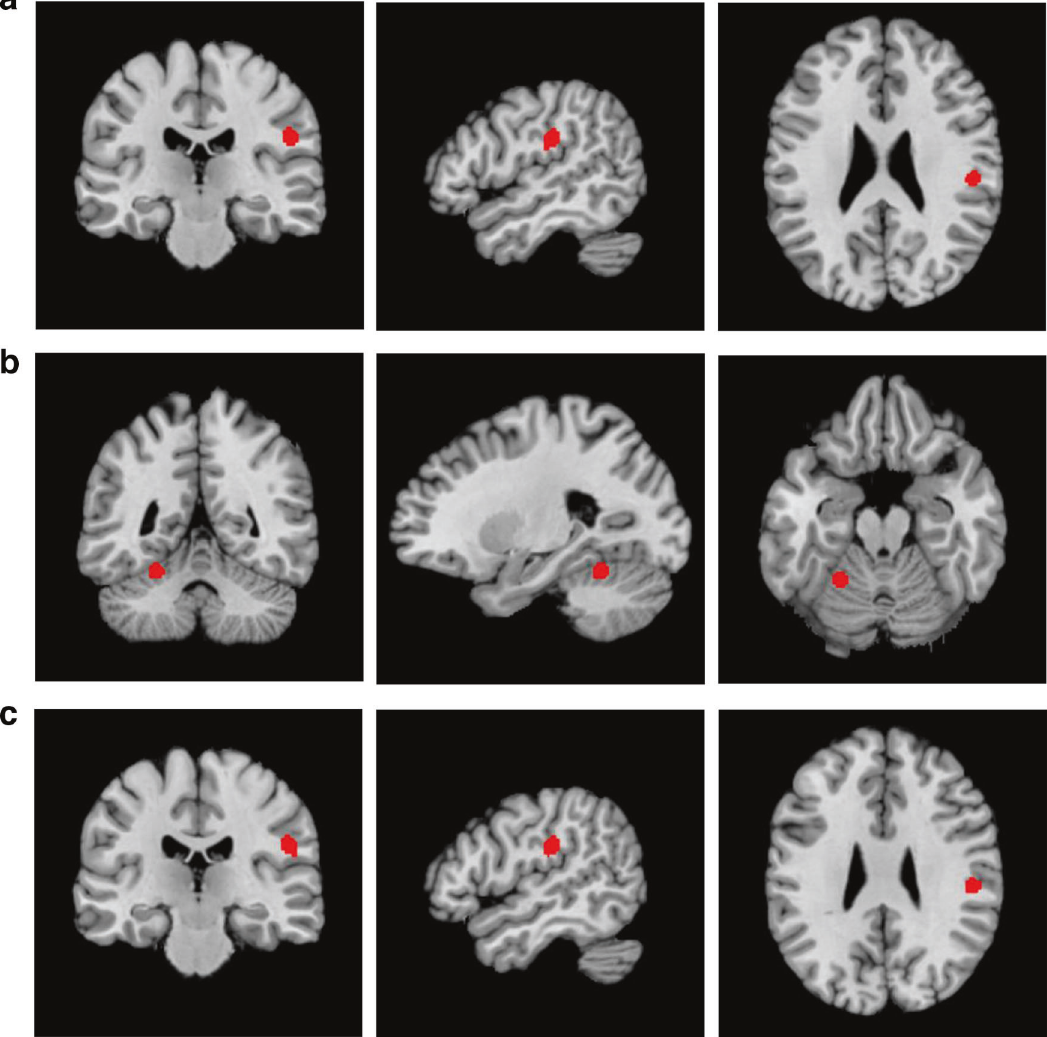
Fig. 2 The location of the clusters of signi fi cant activity during auditory verbal hallucinations (AVHs), found by the meta-analyses of state studies. The location of the signi fi cant clusters, in coronal (left), sagittal (middle) and axial (right) planes, are highlighted in red. a The signi fi cant cluster in the left hemisphere, centred in the inferior parietal lobule and also including the postcentral gyrus and the insula. b The signi fi cant cluster in the right anterior lobe of the cerebellum, centred in the culmen and also including the dentate. c The result of the second meta-analysis of state studies (which included the Diederen et al. [28] study rather than the Sommer et al. [27] study) fi nding a signi fi cant cluster in the left hemisphere, centred in the inferior parietal lobule and also including the postcentral gyrus and the